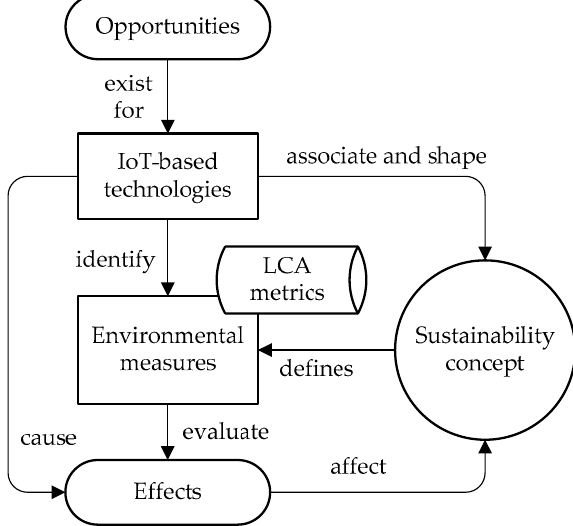
Figure 1. Environmental sustainability and IoT relations.